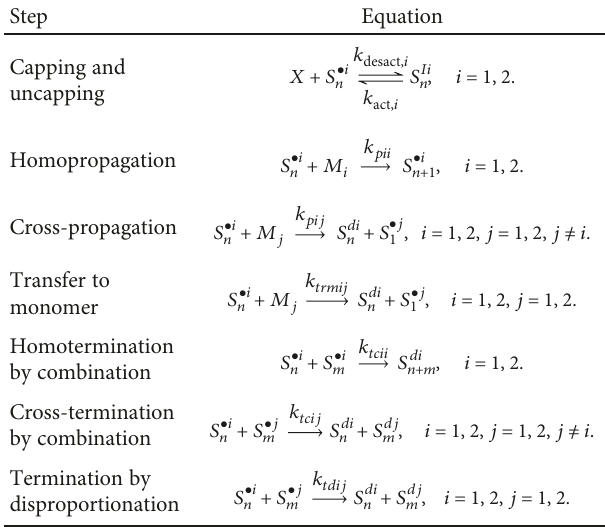
Table 2: Kinetic steps of a nitroxide-mediated copolymerization in terms of the monomer